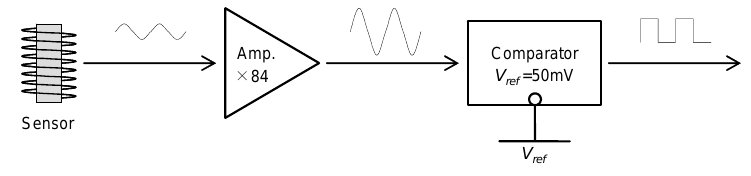
Figure 3. Block diagram of signal-processor in turn-counting fuze.